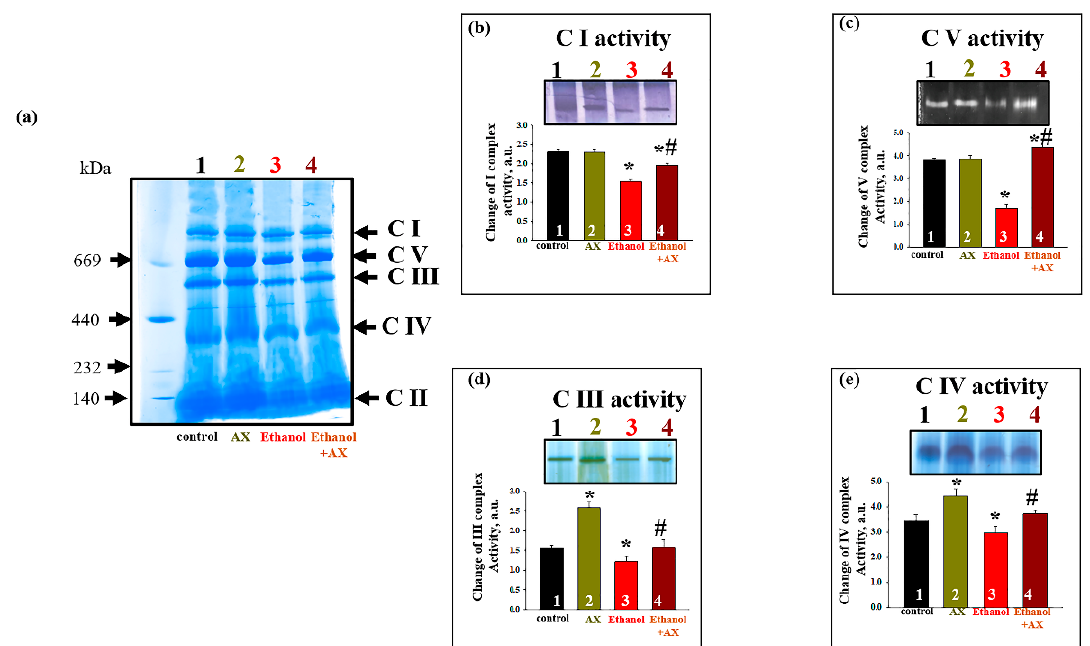
Figure 5. The effect of AX and Ethanol on the activity of respiratory chain complexes and F o F 1 -ATP synthase. ( a )—The native intact RLM isolated from each group was solubilized in the buffer for BNE samples (Materials and Methods Section). Mitochondrial samples were separated by the first dimension BNE, and the gel was stained for the detection of the activity of respiratory chain complexes and F o F 1 -ATP synthase (Materials and Methods Section); ( b )—the change of activity I complex; ( c )—the change of activity V complex; ( d )—the change of activity III complex; ( e )—the change of activity IV complex. The data are presented as mean ± SD of three independent experiments. * p < 0.05 indicates a significant difference in the complex activity compared to the control (Group 1). # p < 0.05 compared with the corresponding value in the complex activity in RLM from ethanol-administrated rats (Group 3). Statistical significance was assessed using the ANOVA type 2 test (Student–Newman–Keuls).